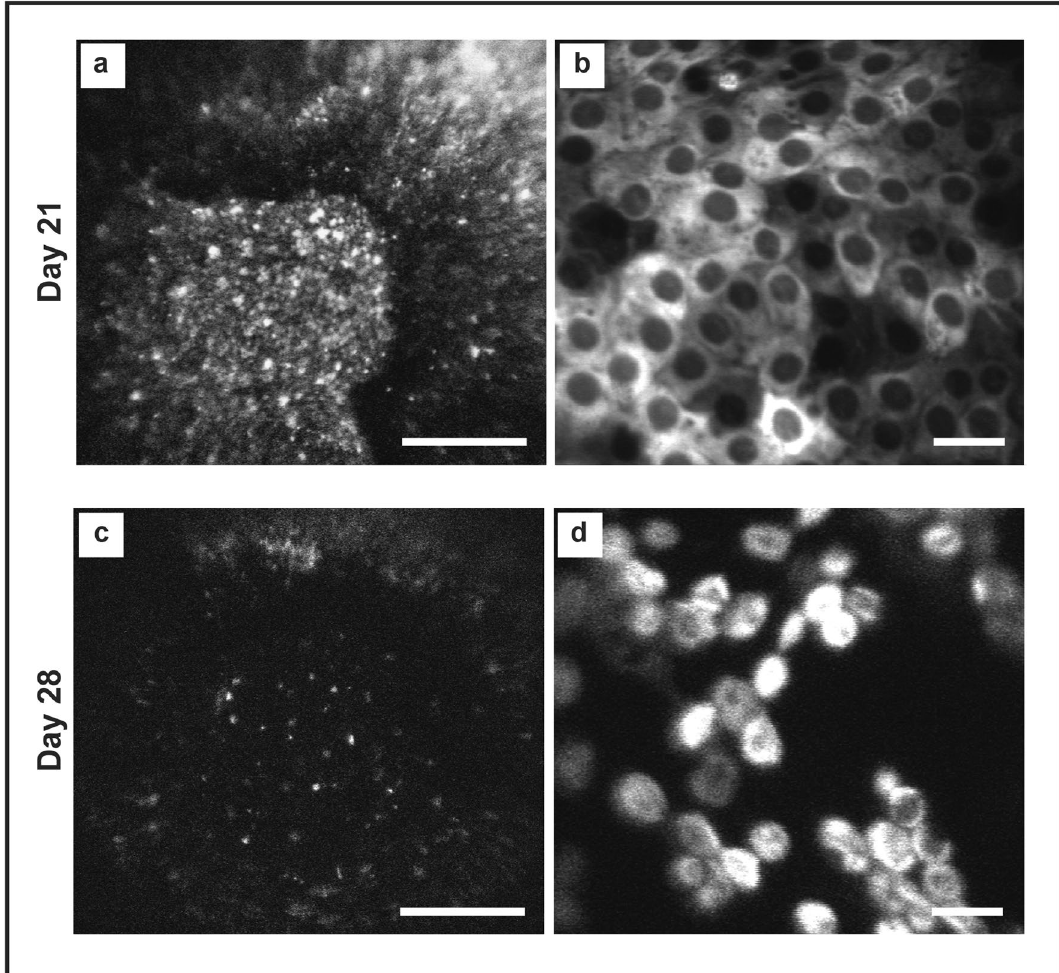
Figure 10. Spectralis images depicting an event of acute graft rejection. ( a ) Low magnification HRA/Spectralis image of a central area of a human DMEK graft, 21 days after transplantation into a rabbit eye. This shows a confluent monolayer of DIR positive cells. Scale bar: 1 mm. ( b ) On day 28 corneal oedema was noted associated with a significant reduction in DIR fluorescence. ( c ) At higher magnifications, a monolayer DIR positive, human endothelial cells were seen at day 21. Scale bar: 50 µm. ( d ) On day 28, the stable monolayer has been replaced with sparse cells that appear rounded and are in the process of detaching from the